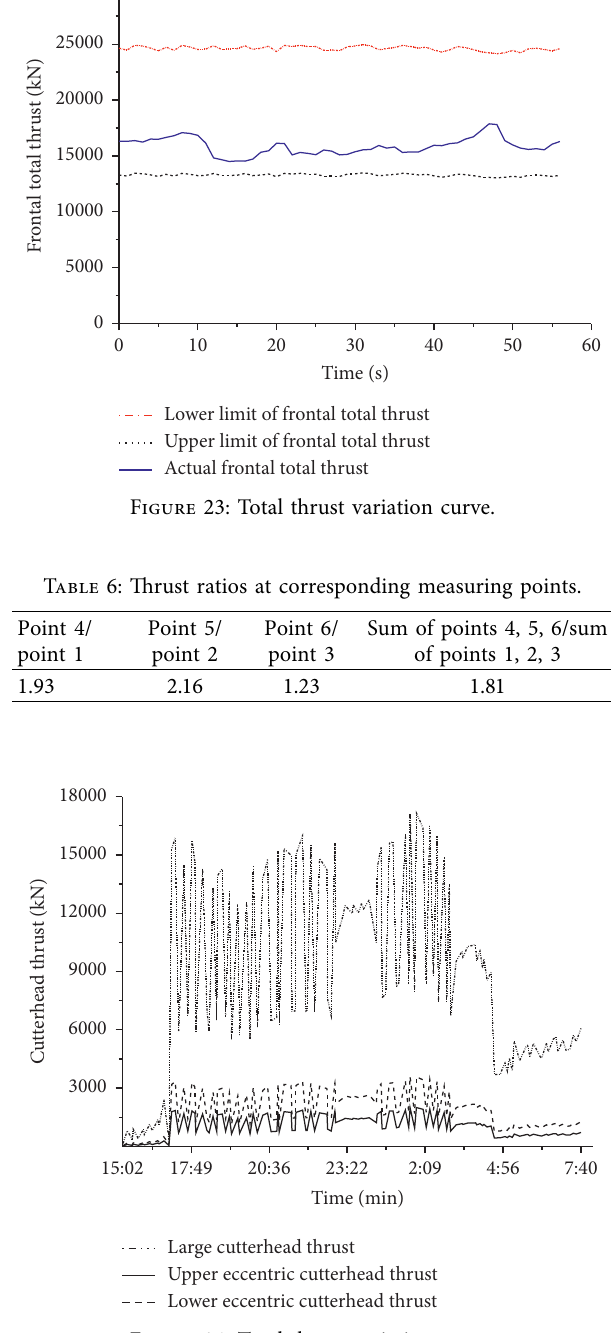
Figure 24: Total thrust variation